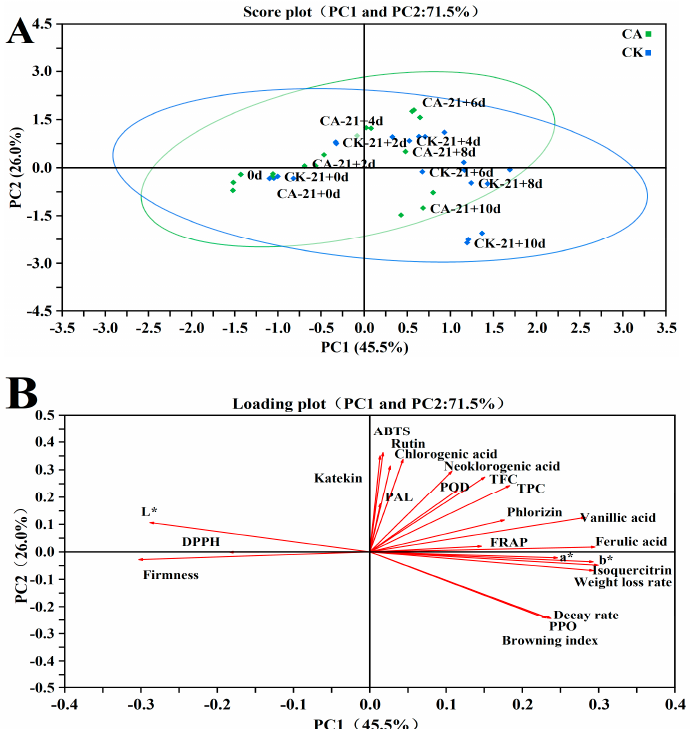
Figure 9. Principal component analysis score plot ( A ) and loading plot ( B ) of yellow peach index parameters for different treatments with three replicates for each treatment.